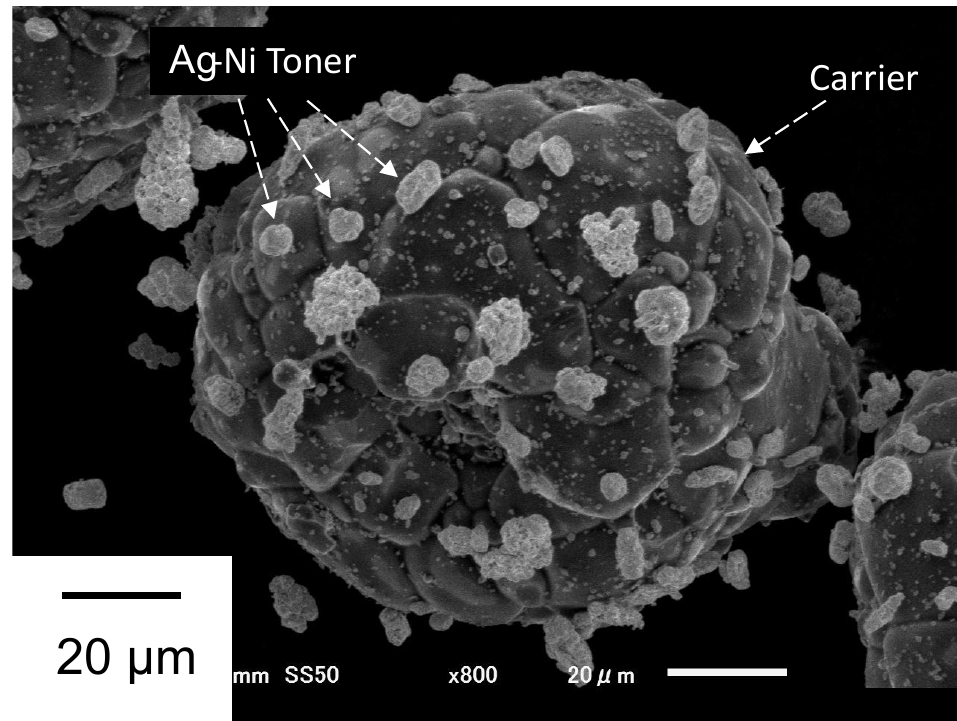
Figure 3. SEM image of the developer comprising a P-02 carrier particle and Ag–Ni composite toner